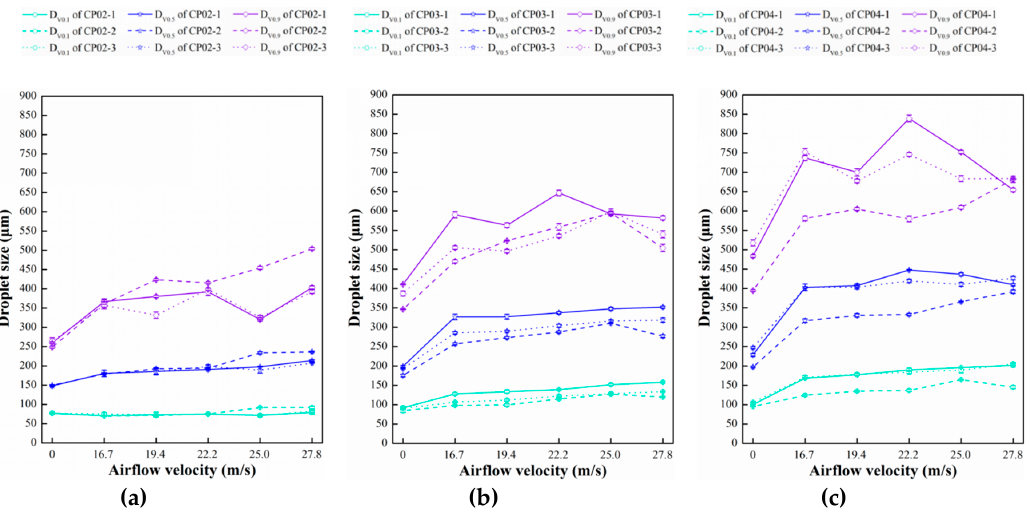
Figure 6. ( a ) Variation of D V0.1 , D V0.5 , and D V0.9 of CP02 nozzle with the airflow velocity; ( b ) variation of D V0.1 , D V0.5 , and D V0.9 of CP03 nozzle with the airflow velocity; ( c ) variation of D V0.1 , D V0.5 , and D V0.9 of CP04 nozzle with the airflow velocity.